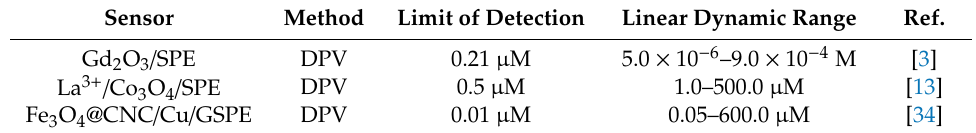
Table 3. A number of characteristics of the screen-printed electrode (SPE) in VEN electrochemical detection.